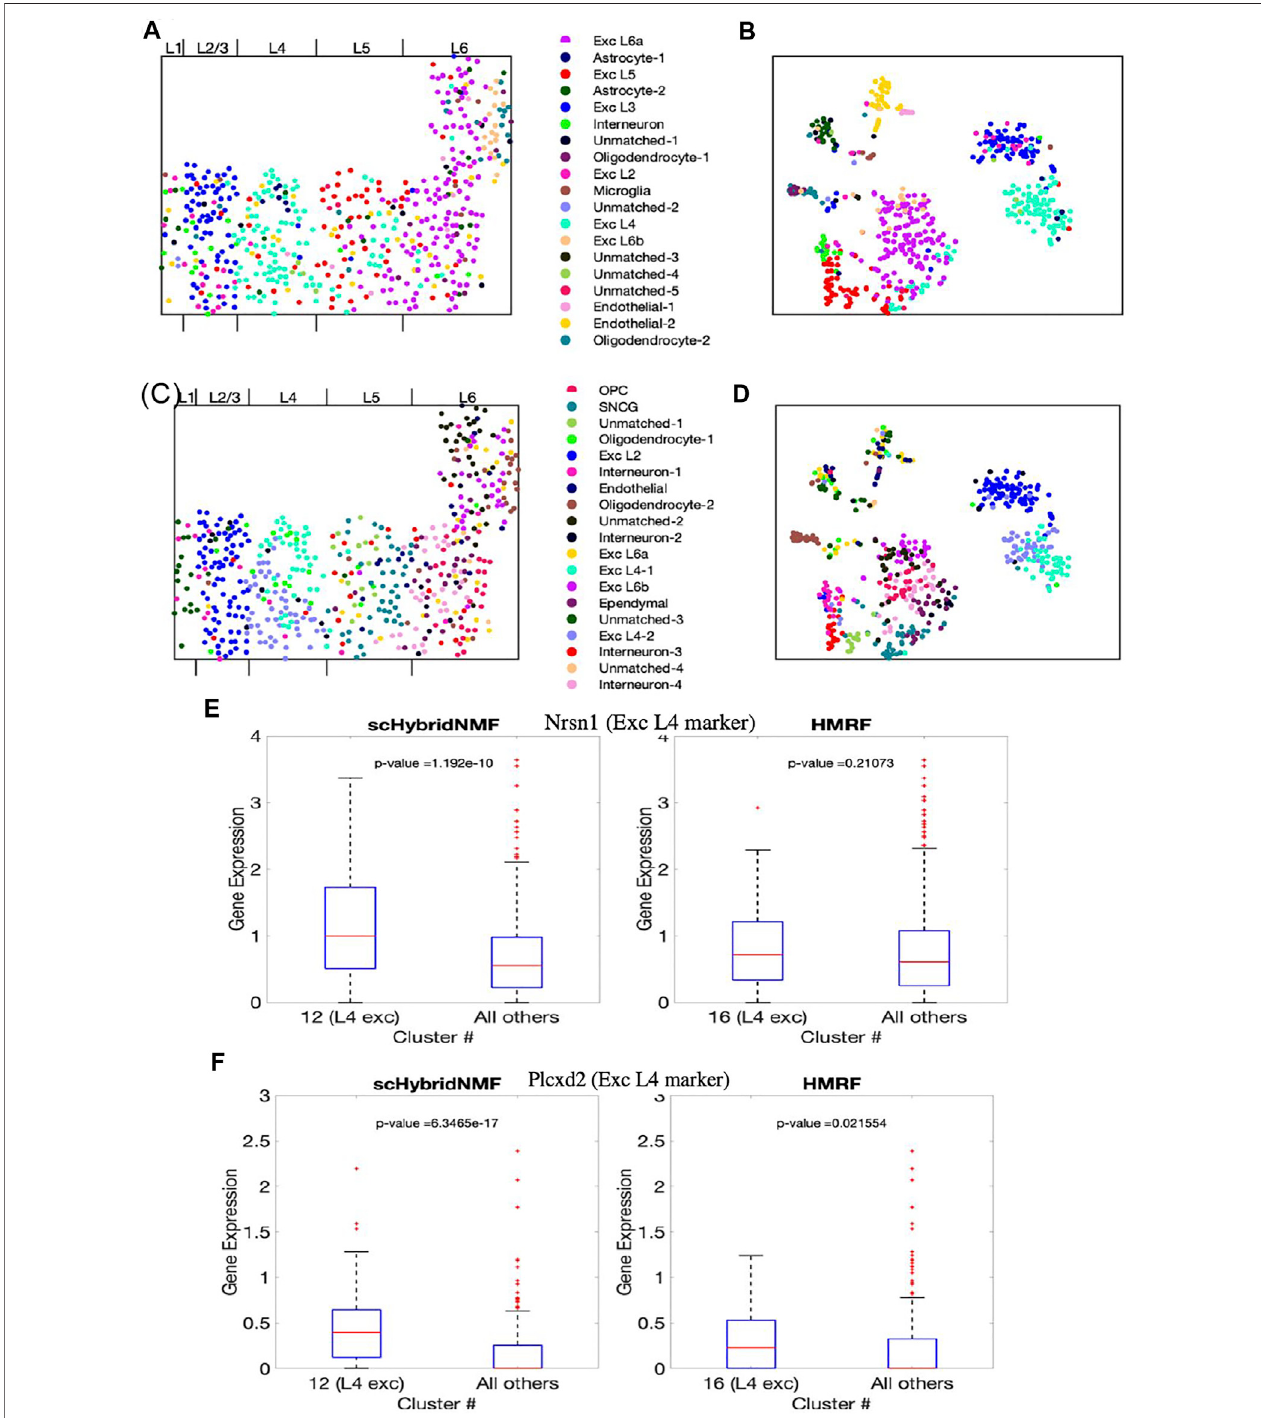
FIGURE 5 | The clustering results of scHybridNMF and HMRF on seqFISH+ data. (A,C) Cells visualized in spatial locations with clustering labels from respectively scHybridNMFandHMRF. (B,D) Cellsvisualizedint-SNEplotsofgeneexpressionwithclusteringlabelsfromrespectivelyscHybridNMFandHMRF.Theclusterlabelsare shown in the middle. The layers are labelled by Dries et al. (2021). (E,F) Box plots of the expressions of Nrsn1 and Plcxd2 in cells in exc L4 clusters vs all other cells. p -values were calculated with a two-sample t -test that tested if the population mean of exc L4 clusters were larger than that of the rest of the cells.